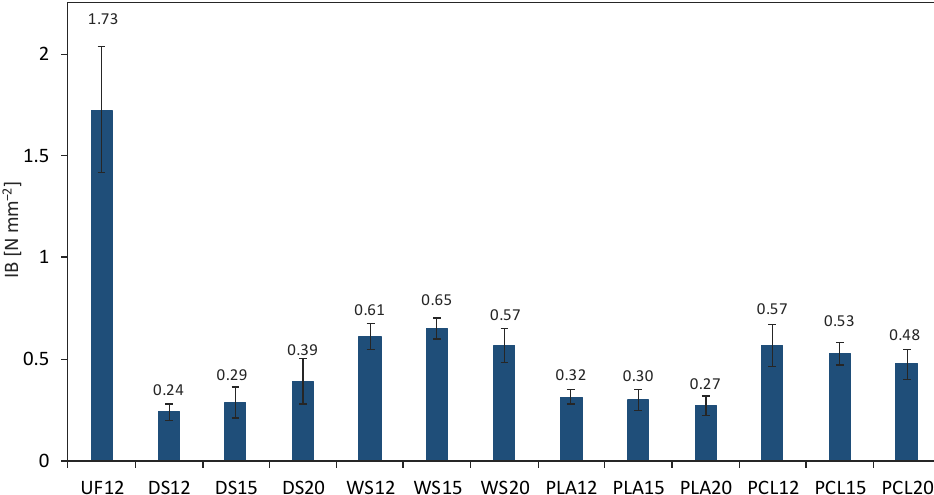
( a ) ( b ) Figure 5. Two representative forms of damage after the IB test ( a ) in the core layer; ( b ) near-surface zone. Scanning electron microscopy (SEM) was used to analyze the bonding quality of HDF with biopolymers and UF resin directly at the microstructure scale. The photos in Figure 6 are presented for each of the produced variants of panels, and were marked with arrows to exemplify the characteristic areas that clearly show the wood fiber covered by the binder used, and in the case of DS samples, how powder grains are visible. There is a visible increase in the number of biopolymers covering the fibers with increasing resina- tion. The SEM pictures show the difference between the bonding of PLA and PCL with fibers, and the reference board based on UF resin. The binder was not distributed uni- formly, and places where the fibers are fully covered by the biopolymer were observed in HDF with PLA and PCL, which potentially affected the mechanical and physical proper- ties. SEM photos of PLA-based composites with the addition of agricultural by-product fibers show poor fiber-to-matrix adhesion, voids, and fiber breakage [68]. Song et al. [50], performed an SEM analysis, proving that the addition of 10% PLA in a fiberboard covers insignificant part fibers, which causes gaps between the fibers. The addition of 30–50% PLA causes the penetration of PLA into the gaps between fibers, which has a positive effect on water resistance and dimensional stability. Sivakumar et al. [69] observed an even distribution of banana leaf fiber with thermoplastic cassava starch as a strong adhe- sive matrix, which improved the mechanical properties of the bio-composites. The com- posite–water interaction (like TS, WA, and SWA) can be dependent on the tested panels’ microstructure and binder distribution.